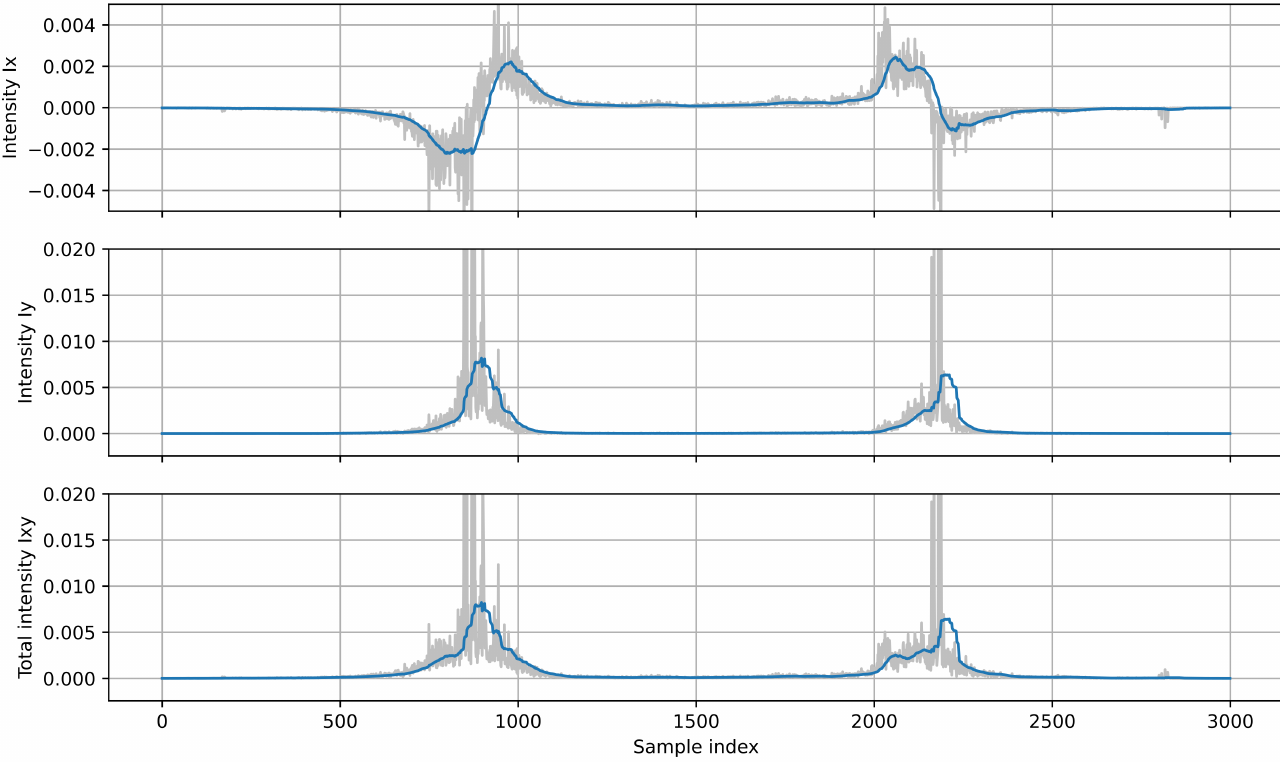
Figure 3. Plots of sound intensity: I X , I Y and total intensity I XY , calculated for two vehicles moving in opposite directions (first: left to right, second: right to left). Light lines show unprocessed signals, dark lines show filtered intensity